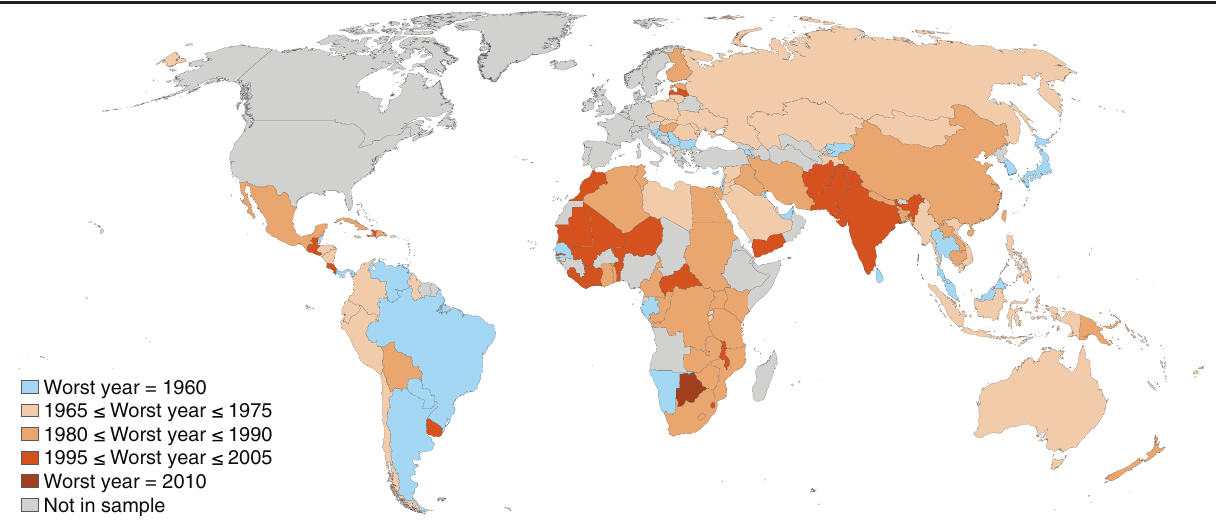
Year of Worst Gap Among Countries Where It Got Worse Before It Got Better.